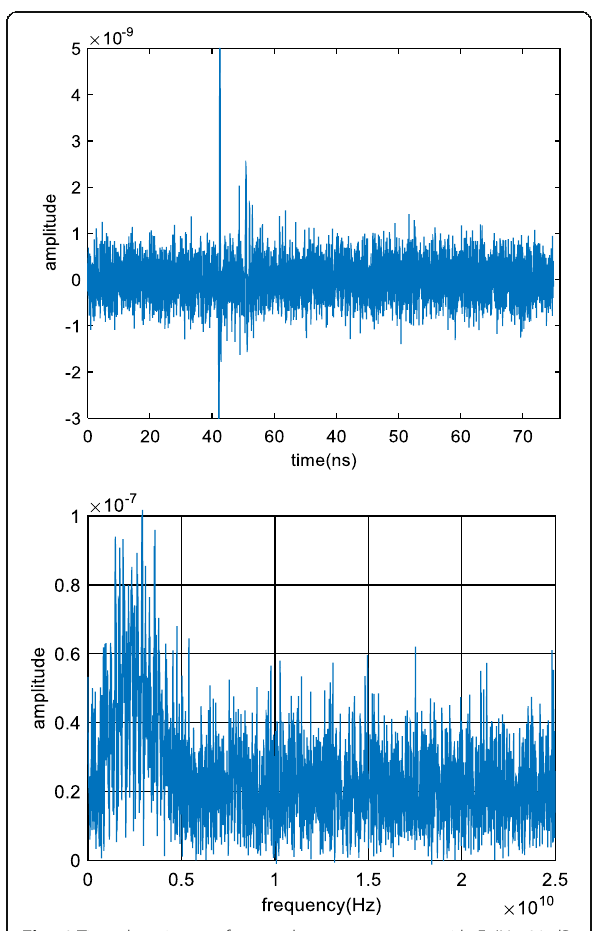
Fig. 6 Time domain waveform and energy spectrum with E b / N 0 =30